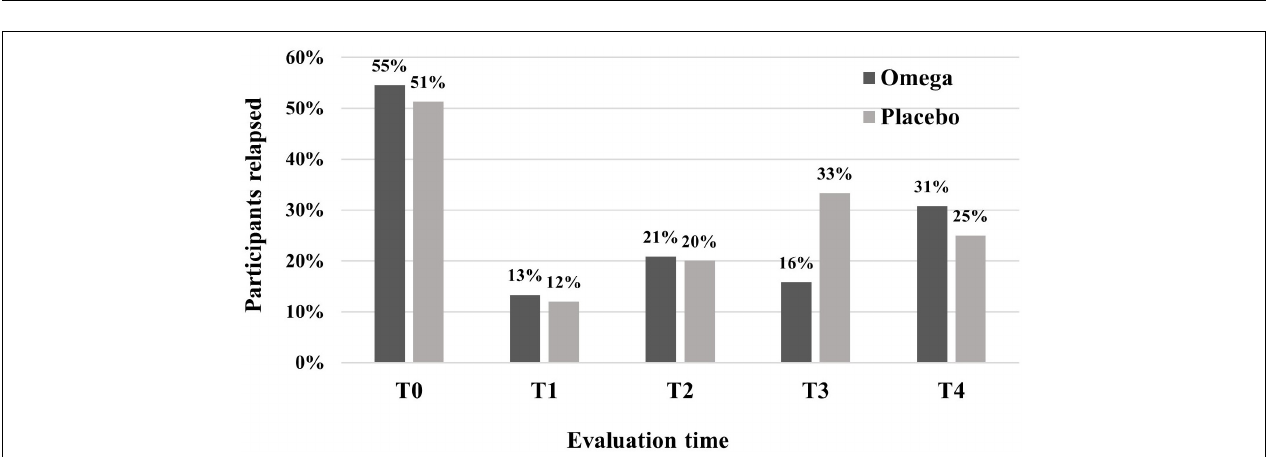
p = 0.70] and dependence severity [Wald χ 2 (4) = 0.95, p =